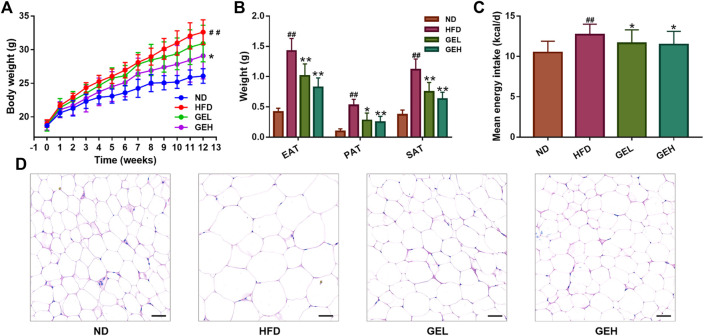
Effects of GE treatment on the abnormal weight gain induced by HFD. (A) Body weight. (B) White fat tissue weight. (C) Energy intake. (D) H&E staining of EAT tissues (200× magnification, scale bars = 50 μm). n = 8 per group. #
p <0.05 or ##
p <0.01 vs. the ND group. *p <0.05 or **p <0.01 vs. the HFD group.